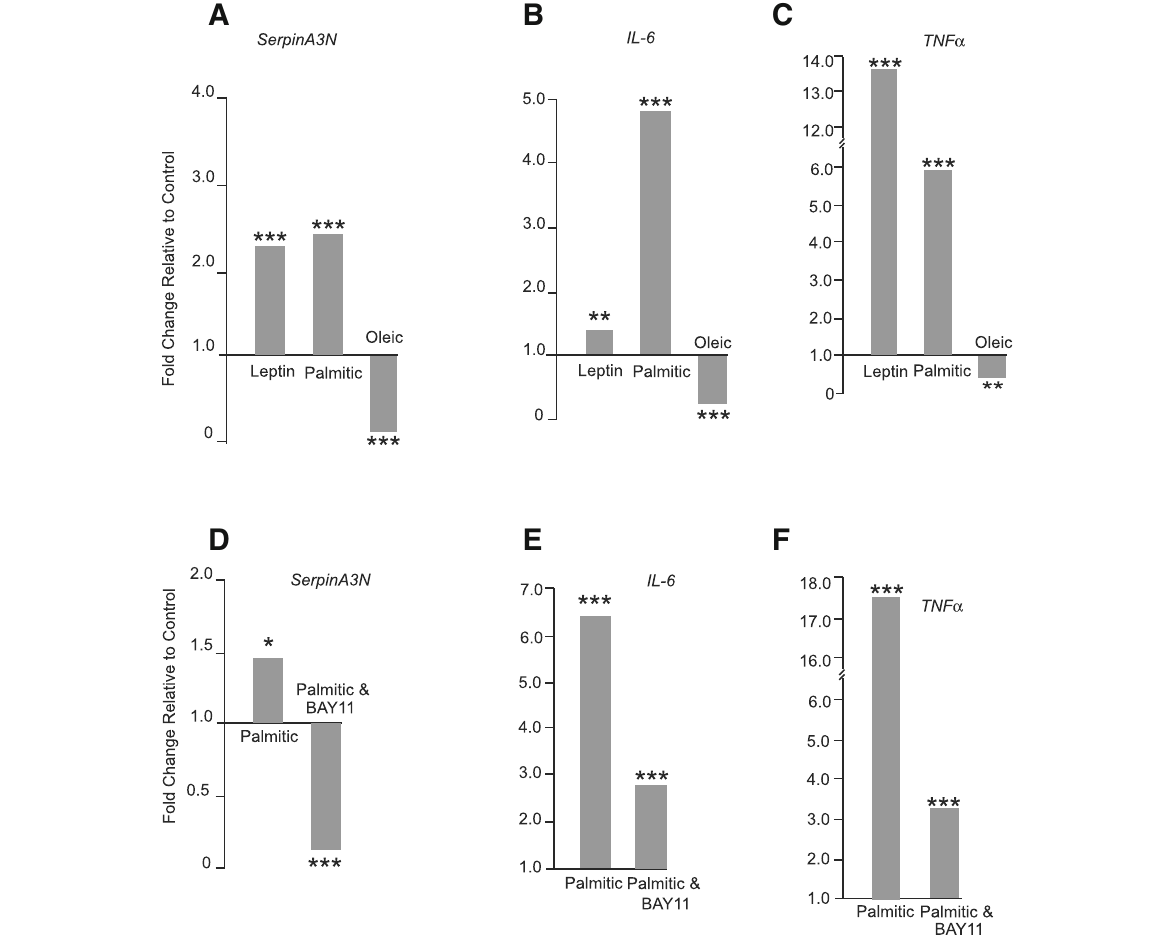
Fig. 8 a – f In mHypoE-N42 cells, a – c SerpinA3N, IL-6 and TNF α gene expression were all upregulated by leptin and palmitic acid challenge and downregulated by oleic acid. d – f The upregulation of SerpinA3N, IL-6 and TNF α gene expression by palmitic acid was blocked by the NK κ B inhibitor BAY11. P < 0.05, *** P < 0.001, ** P < 0.01. NS not